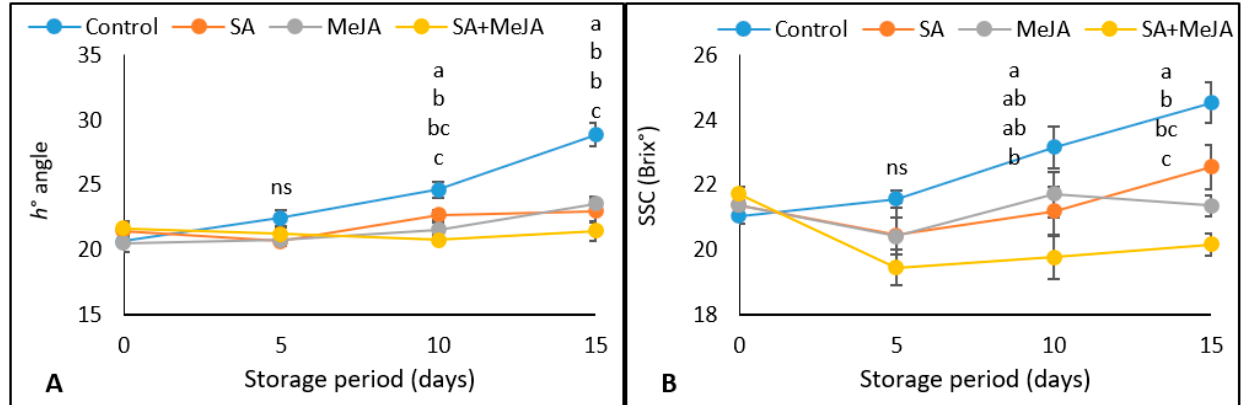
Figure 3. Effects of salicylic acid (SA), methyl jasmonate (MeJA), or their combination postharvest treatments on ( A ) h° angle and ( B ) solid soluble content (SSC) of pomegranate arils stored at 5 °C